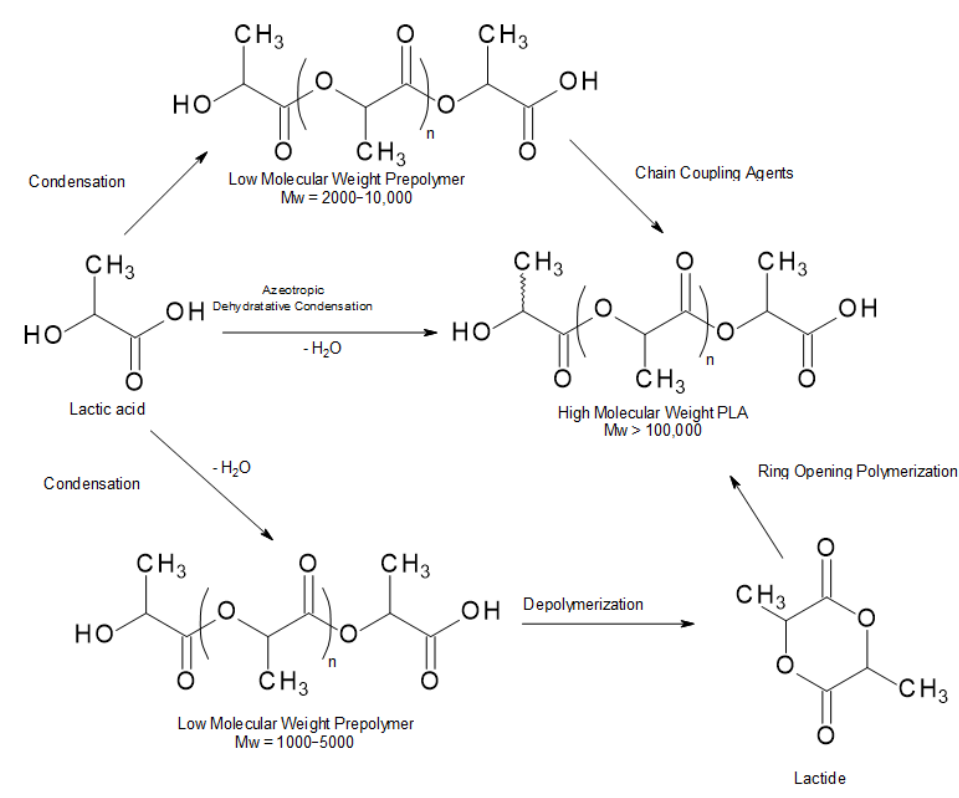
Figure 6. Manufacturing routes to polylactic acid [26].